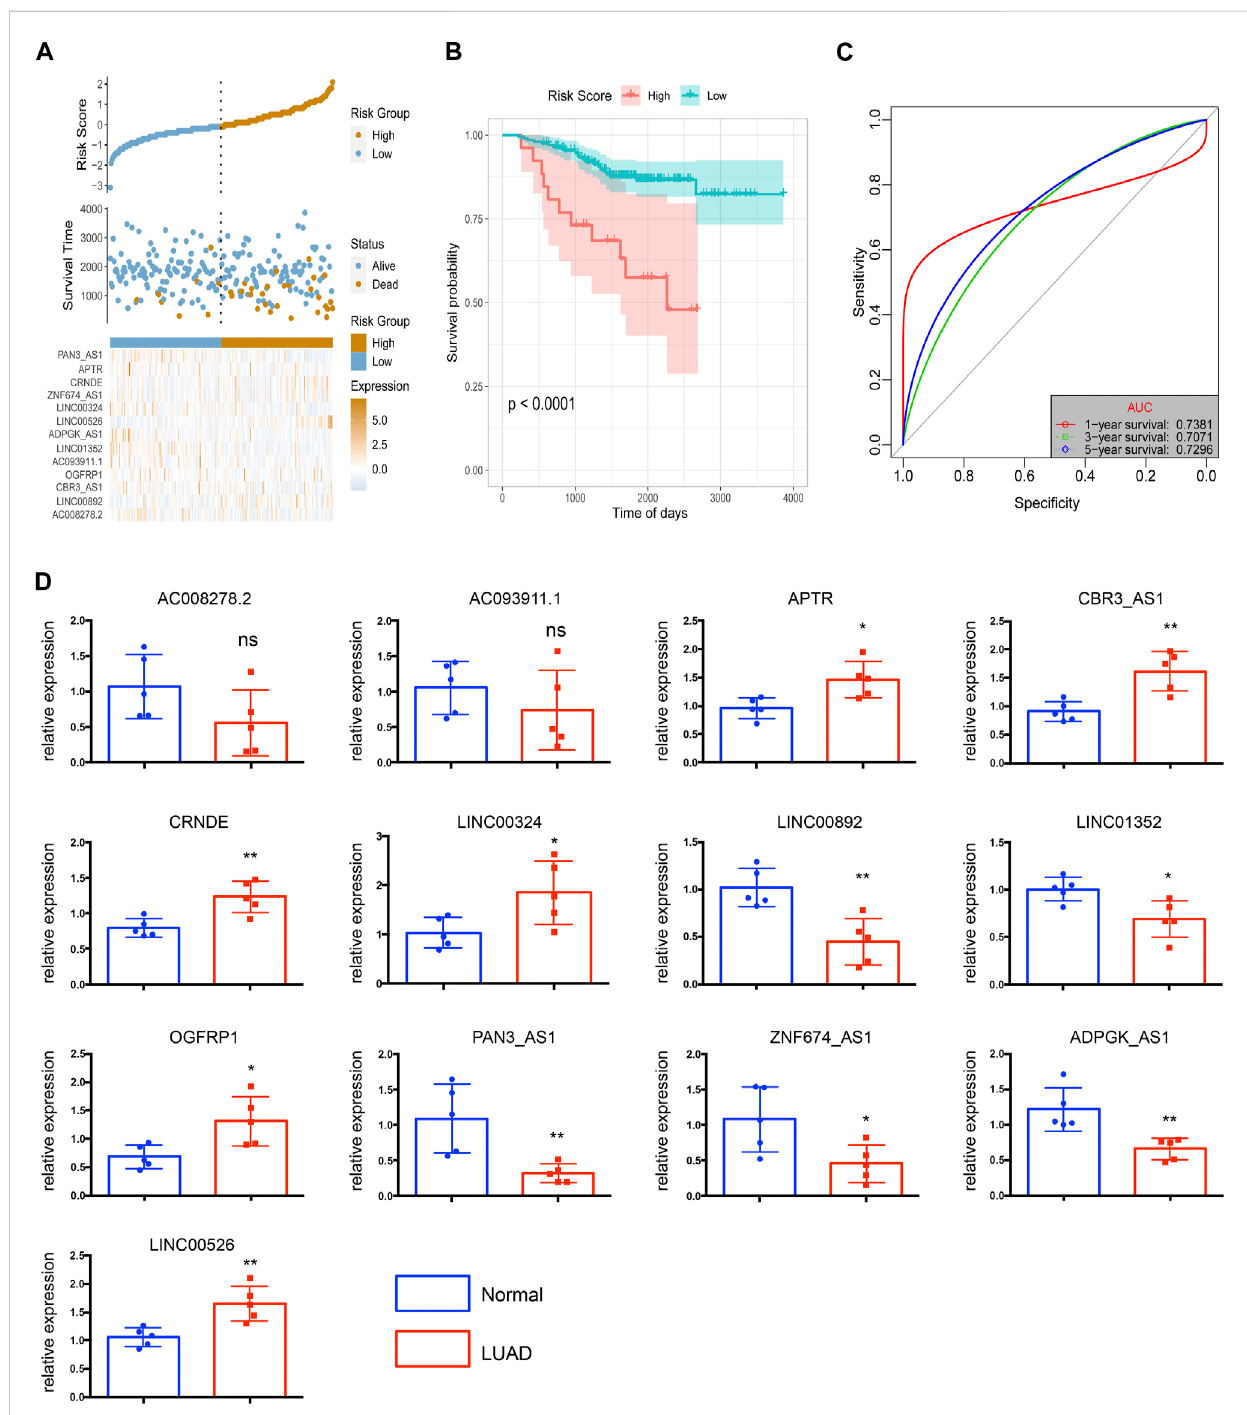
FIGURE 7 The risk score model was validated bythe external dataset GSE31210. (A) The distributionof risk scores. (B) The survival probability was higher in the high-risk group compared with the low-risk group. (C) The 1-, 3-, and 5-year ROC curves of the external dataset. (D) Relative expressions of 13 key lncRNAsinLUADtissues(LUAD)andcorrespondingadjacentnon-tumoroustissues(normal). N =5ineachgroup.* p < 0.05,** p < 0.01,*** p < 0.001,ns= no signi fi